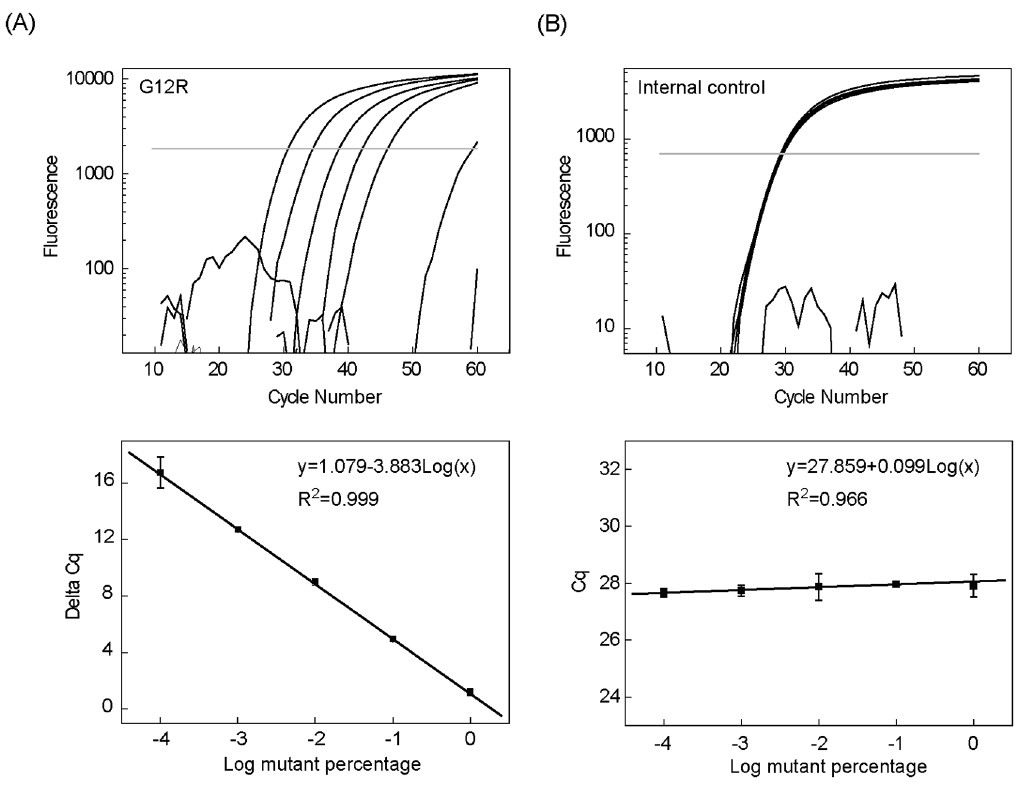
Figure 3. Quantitative performance of the two-color duplex real-time Bi-PAP. (A) Amplification curves of 100%, 10%, 1%, 0,1%, 0.01%, and 0% G12R mutant (from left to right) in the presence of 100 ng wild-type genomic DNA (upper panel). The linear relationship of the Cq difference between the mutation and the internal control ( D Cq= Cq – Cq IC ) with respect to the logarithmic mutation percentages (lower panel). (B) Amplification curves of the internal control with different mutant percentages (upper panel). The linear relationship between the Cq values of the internal control and the logarithmic mutant percentages (lower panel).